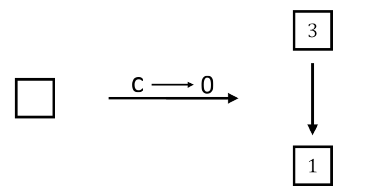
Figure 3: The vector representation of CCA by taking the limit from vector represen- tation of SO ( 4 )